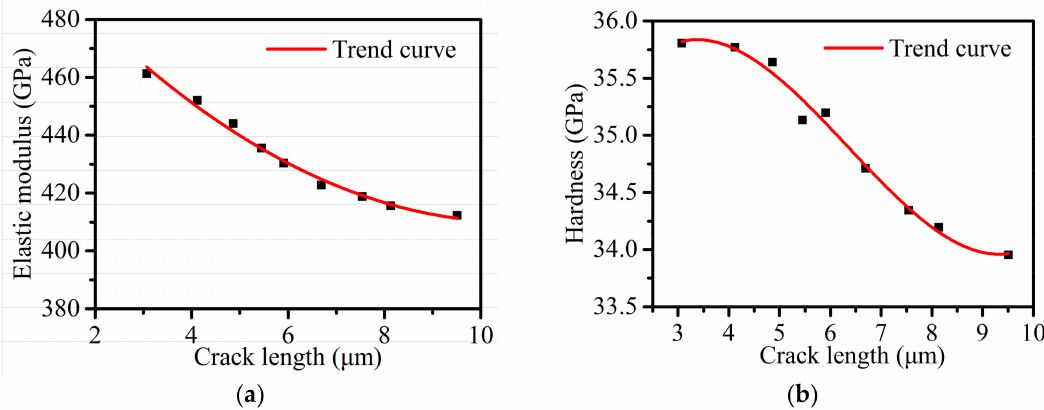
Figure 8. Scanning electron microscopy (SEM) images of indentations at a peak load of 100 mN, 200 mN, 300 mN, 400 mN, 500 mN, 600 mN, 700 mN, 800 mN, 900 mN, and 1000 mN on the 4H-SiC single crystal sample surface.